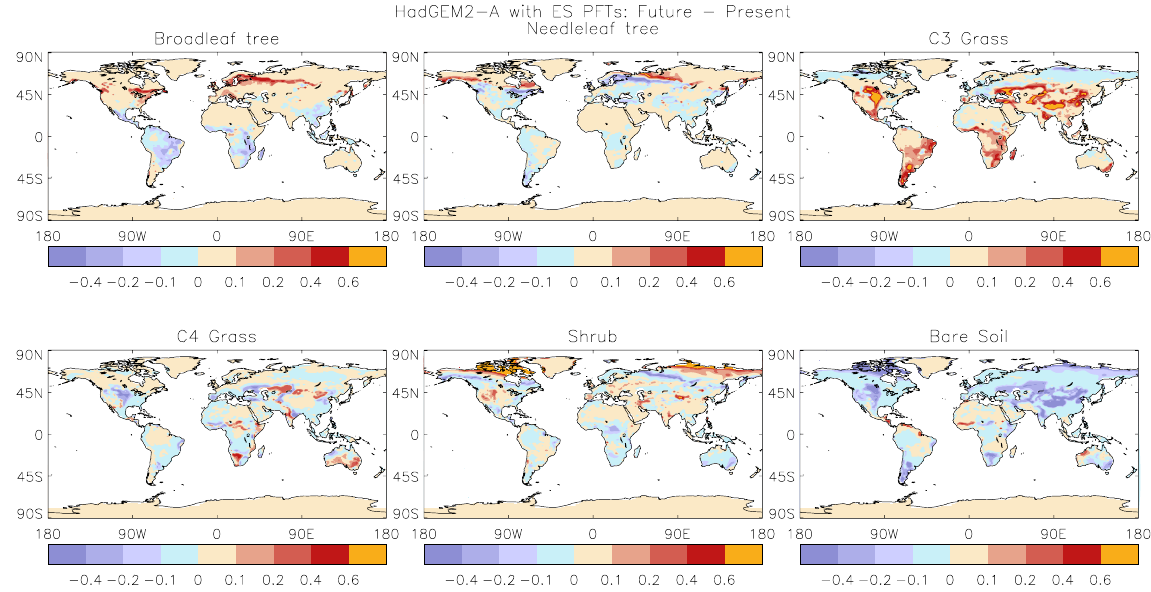
Fig. 15. Changes in land cover between c. 2100 and present-day as simulated by HadGEM2-ES in the CMIP5 RCP8.5 scenario and applied in HadGEM2-AE present and future timeslice